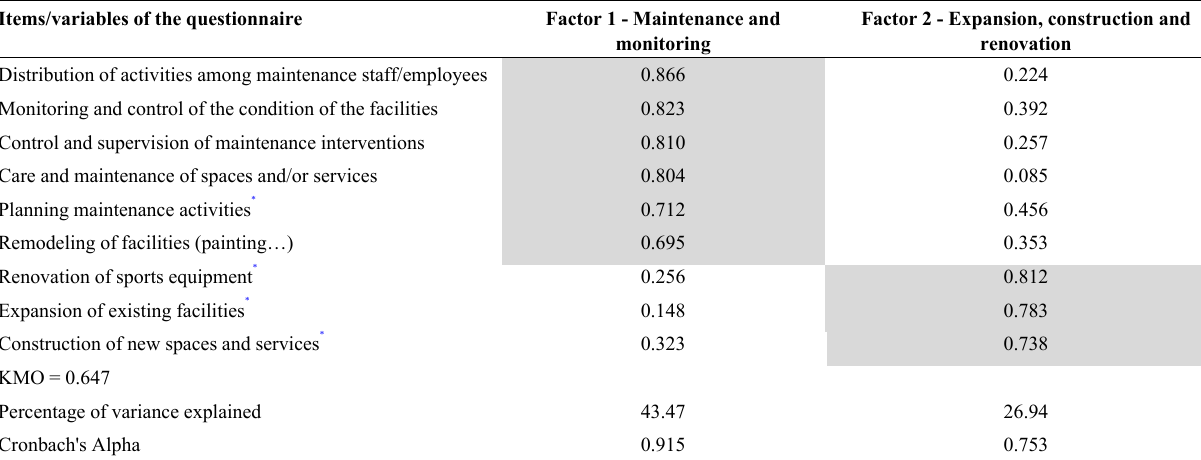
Table 5 - Key components analysis: Maintenance.